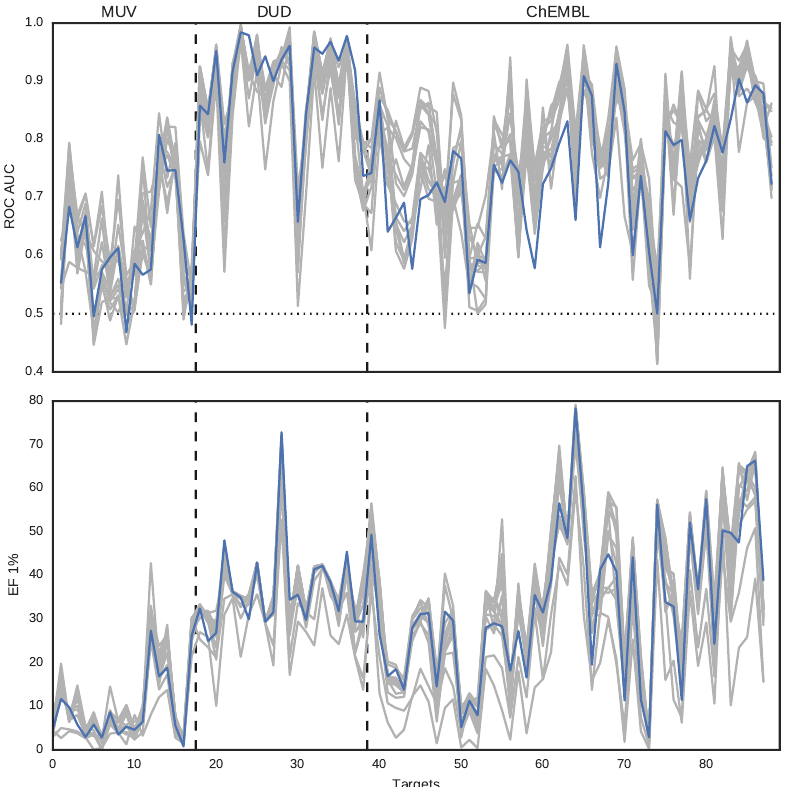
Figure 3. ROC AUC values (top panel) and EF 1% (bottom panel) for DeCAF (blue line) and 14 fingerprints (gray lines). The three data sources are separated with dashed lines. The baseline ROC AUC (0.5, results obtained for random predictions) is plotted with dotted